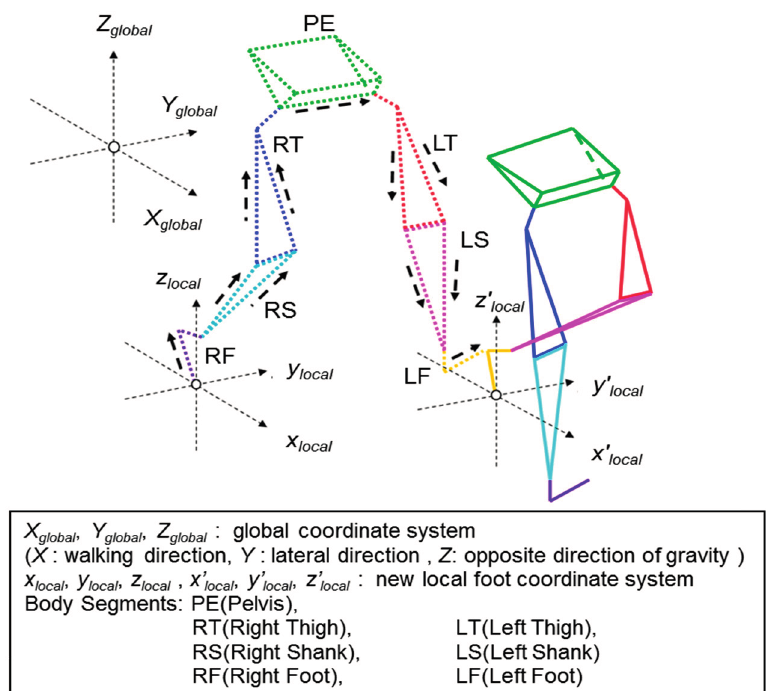
Figure 4. Wire frame model of the volunteer. The X global , Y global , Z global represent the global coordinate system, where the X global axis is the walking direction, the Y global axis is the left-lateral direction, and the Z global axis the vertical direction. The x , z’ y’ local local represent the new local foot coordinate system based on each step of gait. PE, RT, LT, RS, LS, RF and LF represent each of the body